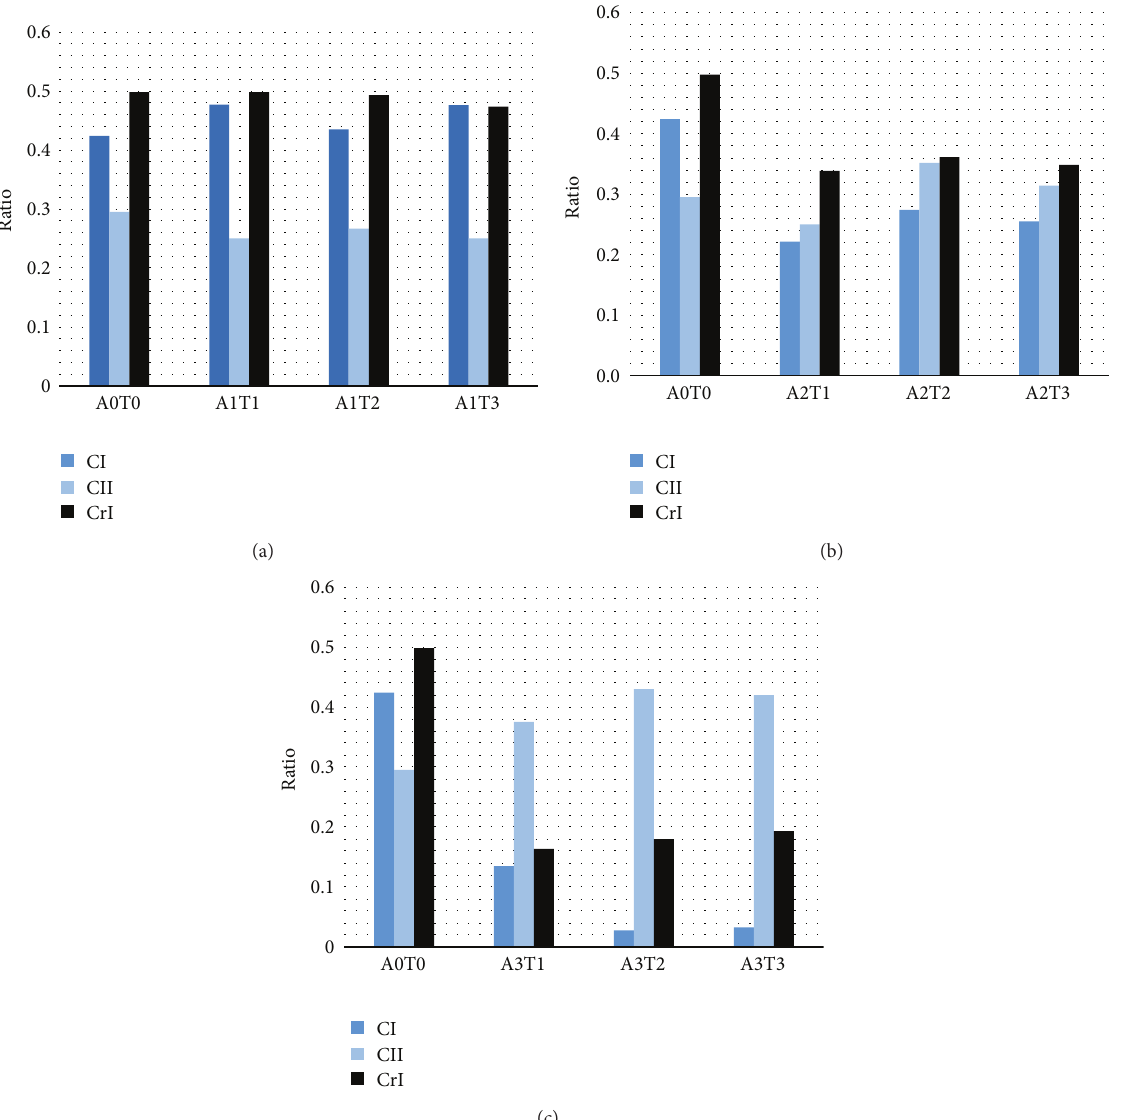
Figure 2: Crystallinity index and ratios of CI and CII for various NaOH concentrations and times. (a) NaOH 10%. (b) NaOH 20%. (c) NaOH